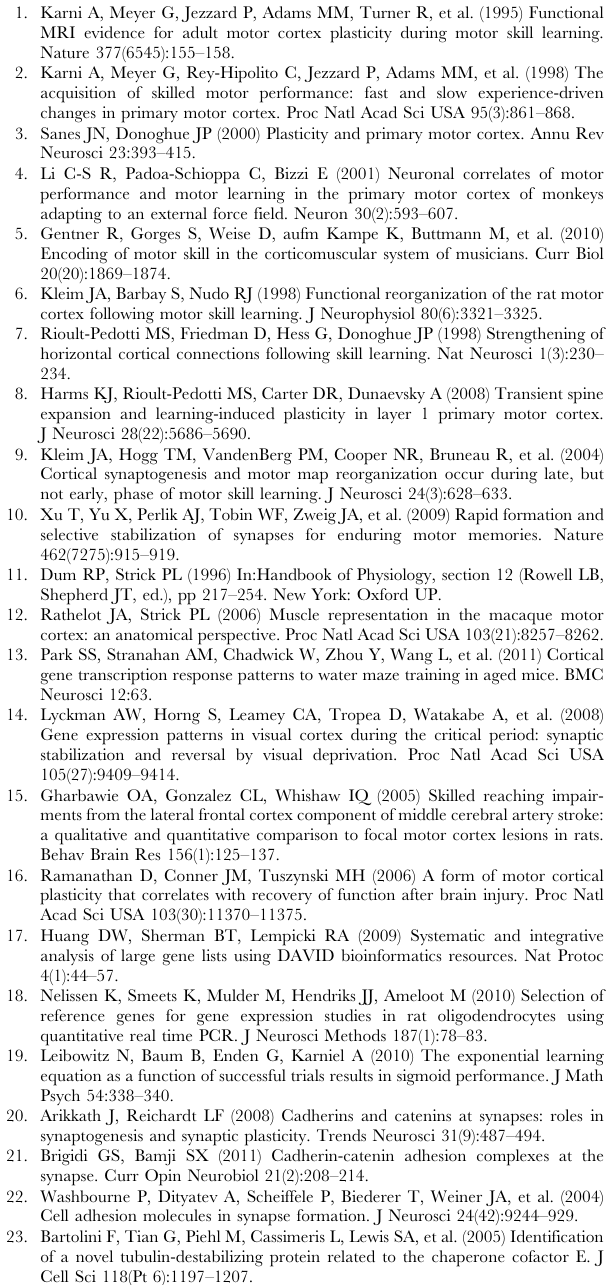
Table S1 A list of all probes differentially expressed in the Reach groups but not in the Sham groups. This list of differentially expressed probes is provided as a supplementary file in the xlsx format, readable by Microsoft Excel. The raw gene expression values of the listed probes for all 20 samples can be found in columns H to AA. Gene expression values of each gene were presented as ratios between signal intensities derived from cy5 (labeling samples from the Reach - or Sham- rats) and those from cy3 (labeling the reference sample from the naı¨ve rat). Name of the file: Table S1.xlsx.